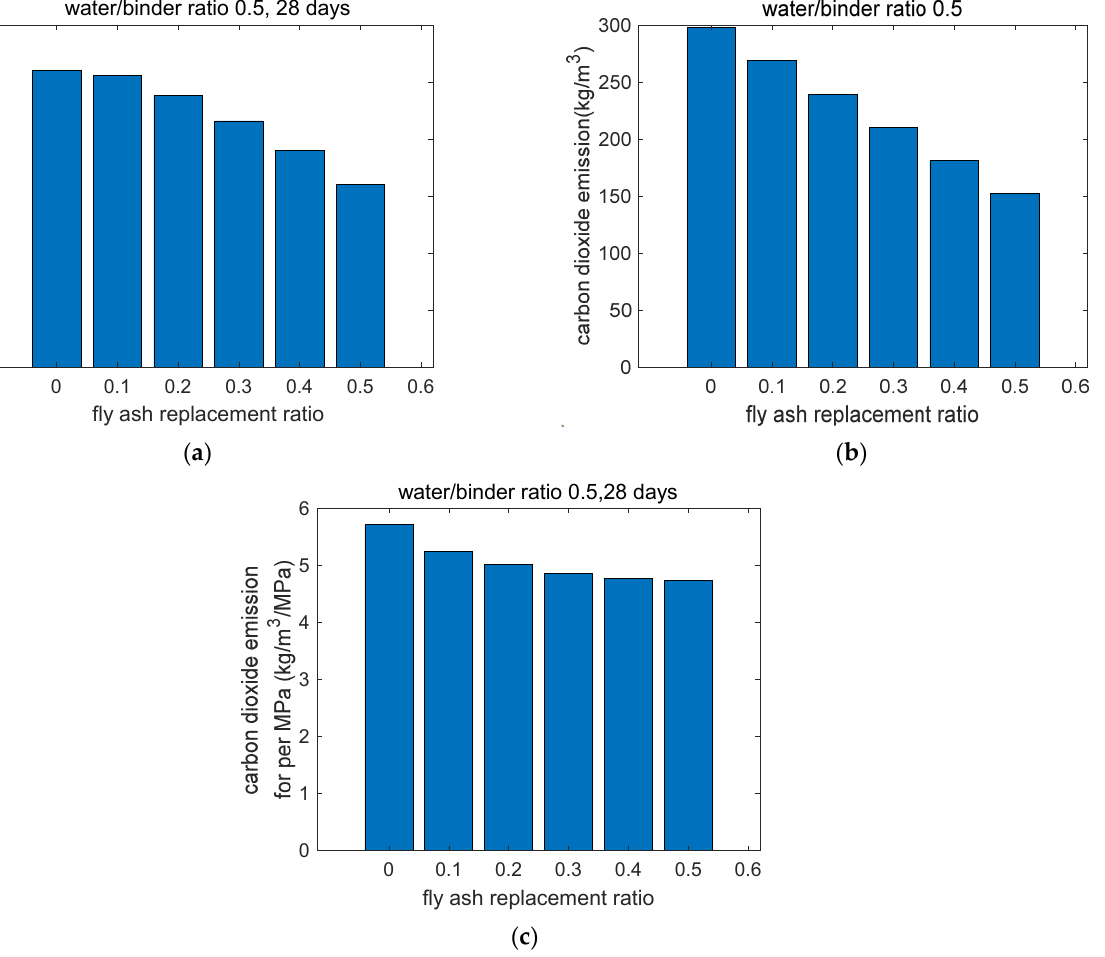
Figure 5. CO 2 emissions for composite concrete with W/B ratio = 0.5 at 28 days. ( a ) Strength at 28 days. ( b ) Total CO 2 emissions. ( c ) CO 2 emissions for 1 MPa strength.